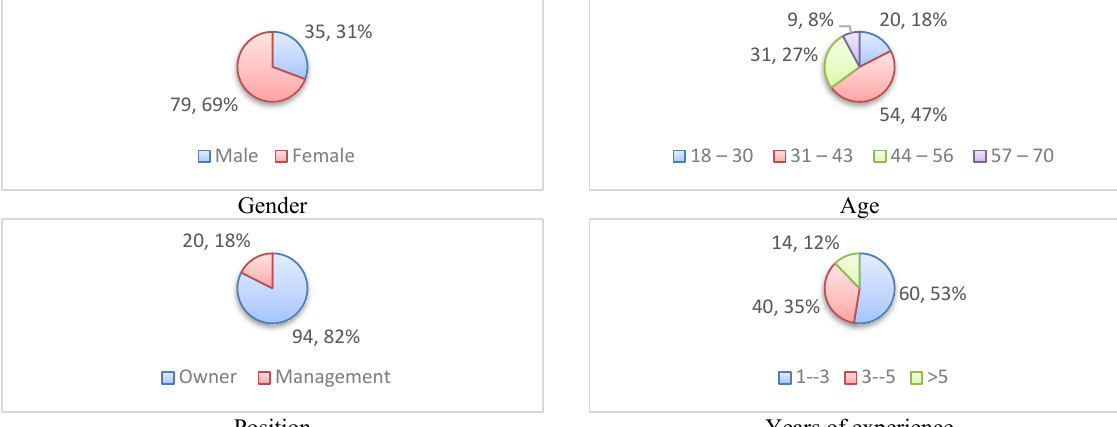
Fig. 2. Personal characteristics of the